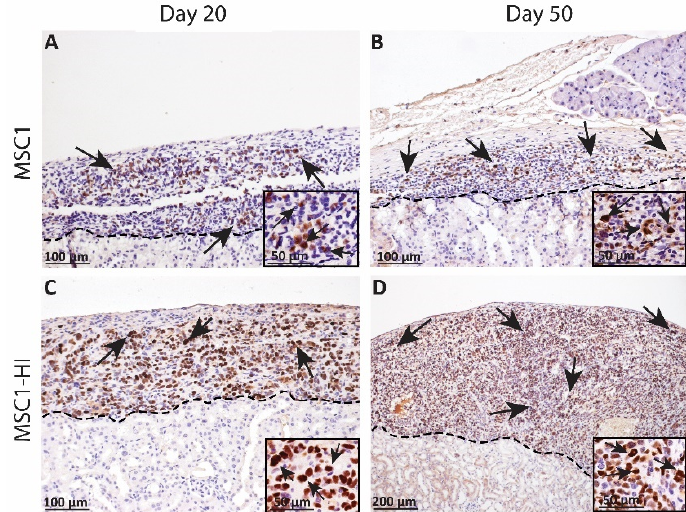
Figure 3. Immunohistochemical analysis of MSC1 and MSC1-HI cell allograft survival. Six million MSC1 ( A , B ) or MSC1-HI ( C , D ) cells were transplanted under the kidney capsule of BALB/c mice. Grafts were collected on days 20 ( A , C ) and 50 ( B , D ) post-transplantation and immunostained for the MSC1 cell marker large T-antigen (brown). Insets are a higher magnification and are included for visualization of large T-antigen positive cells. A dotted line separates the graft (above the line) from the kidney (below line). Sections were counterstained with hematoxylin (blue). Arrows indicate examples of positive staining.